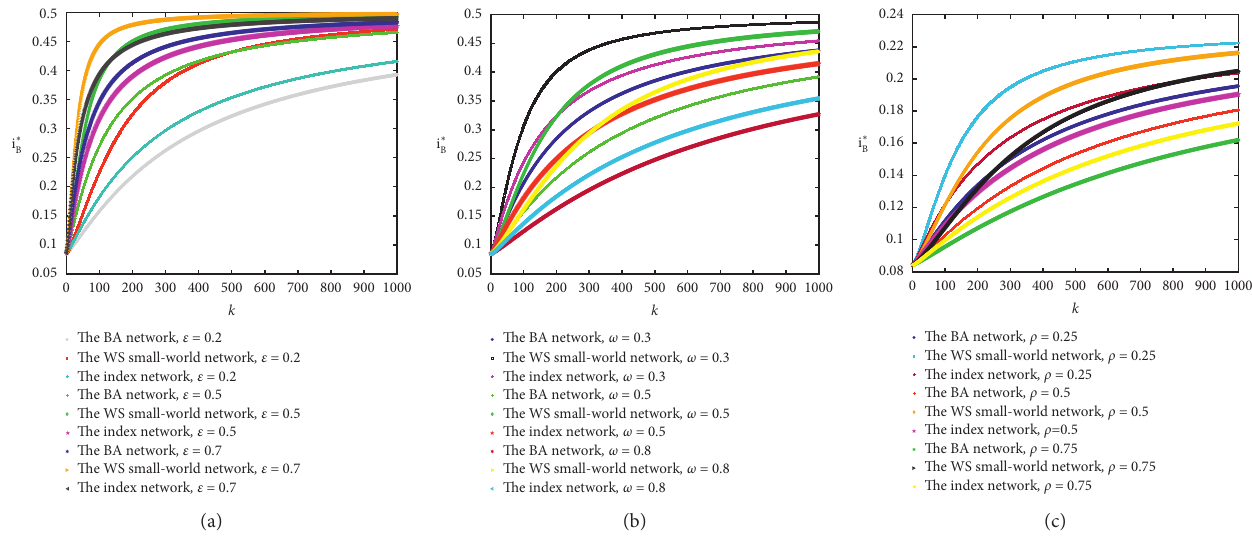
Figure 9: Evolutionary characteristics of the impact of bank transaction counterparty degree k on i ∗ B under different network structures and different bank transaction counterparty business connection degrees ε . (b) The impact of bank counterparty’s degree k on i ∗ B under different network structures and different bank counterparty risk resistance abilities ω . (c) The impact of bank counterparty’s degree k on i ∗ B under different network structures and bank’s counterparty risk information processing ability ρ .